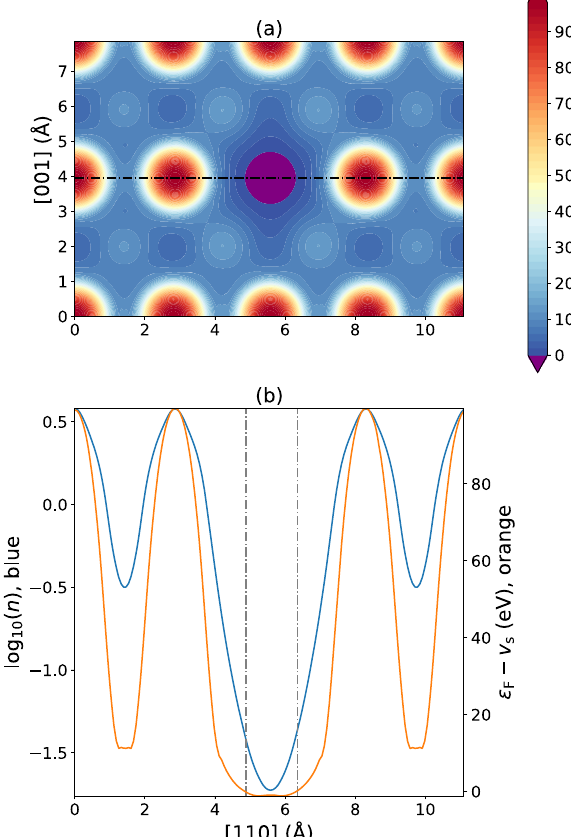
Fig. 4 Creation of a CFR by a monovacancy defect in Pt. a A contour plot of ε HO − v s ( r ) as calculated with PBE along the (1, – 1,0) plane (conventional cubic indices) in the Pt monovacancy supercell. The CFR (purple) surrounds the defect, supporting the conjecture that the formation of a defect is accompanied by the formation of an internal curved surface. Regions within the PAW pseudopotential core radii are only included here to make the image clearer. For an analogous fi gure in Si, refer to Supplementary Fig. 2. b Logarithm of ½ n ð r Þ(cid:4) (blue) and ε – v the density log HO s ( r ) (orange) plotted along 10 the black line in a . The density decays exponentially as it crosses the border of the CFR, marked by gray vertical